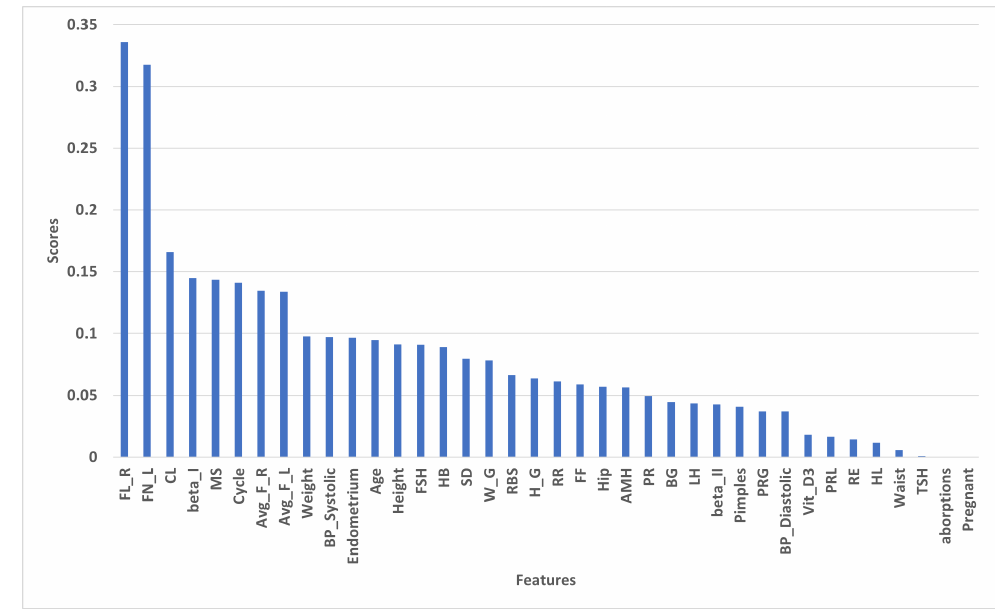
Figure 3. Scores of selected features by